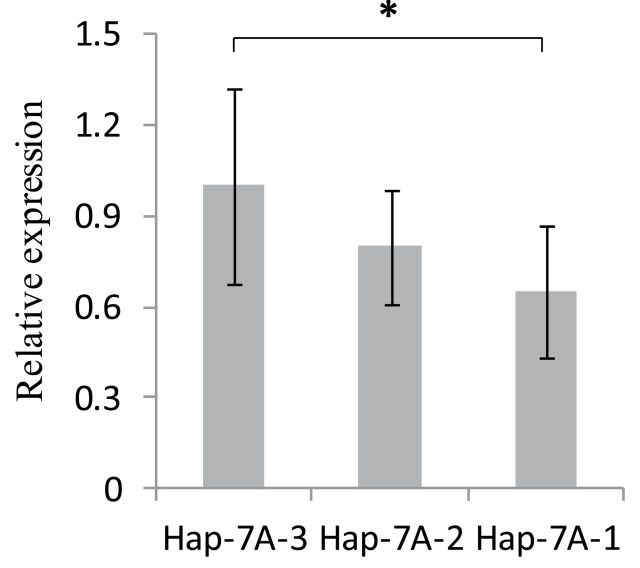
Quantification of the expression of GUS gene driven by each of the three haplotype promoters.